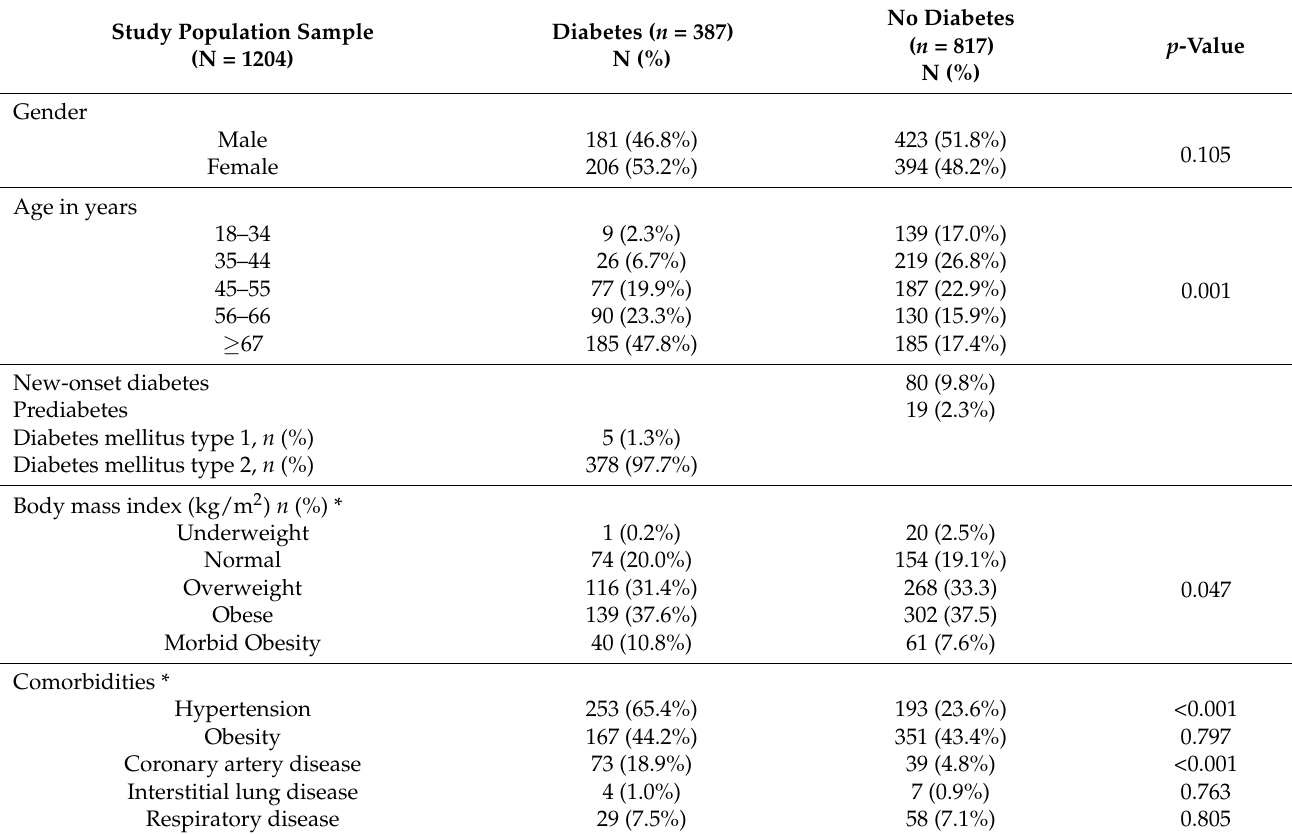
Table 1. Study population demographic data and case management